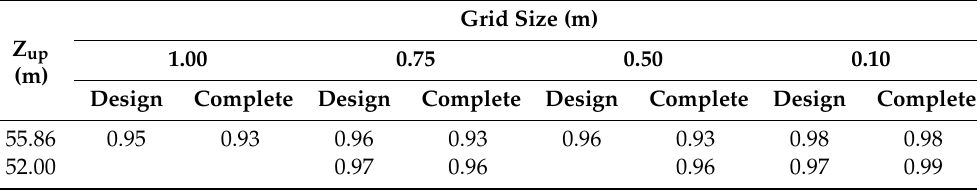
Figure 7. Discretization of solid boundary with two mesh sizes: 0.75 m and 0.1 m. Table 3. Nash coefficient of water level.